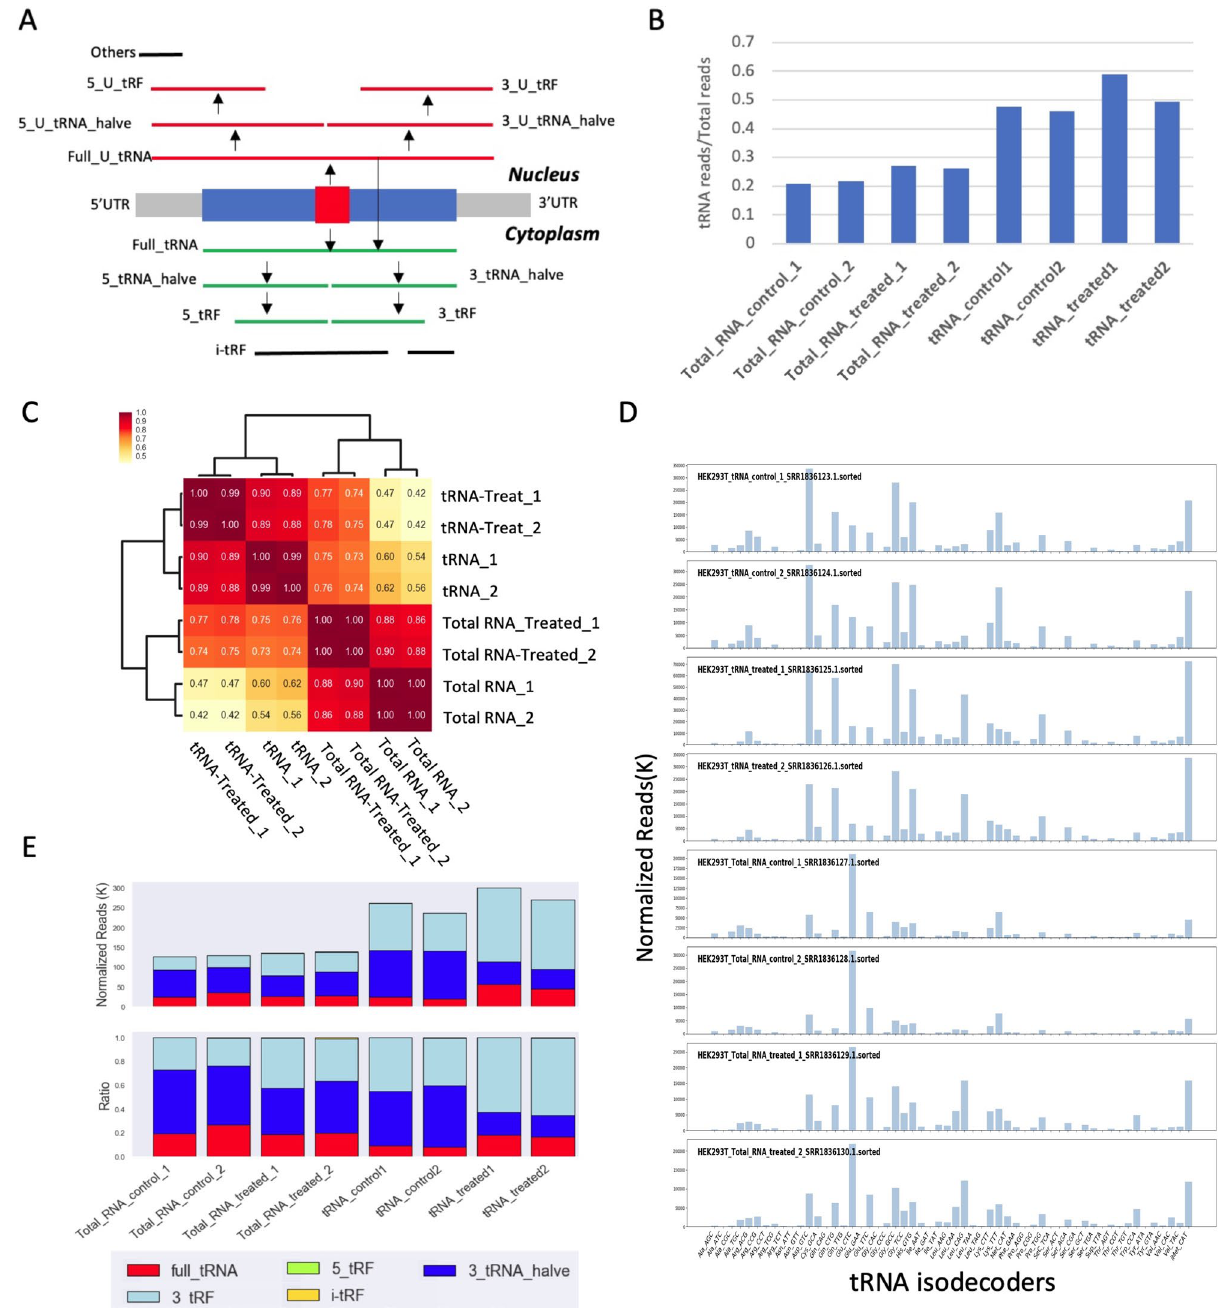
Figure 3. tRNA profiles of HEK293T cells in the DM-tRNA-Seq dataset. ( A ) Cartoon illustrates 12 types of tRF. The arrows represent the direction of tRNA processing; the red and dark blue rectangles in the middle represent anticodon and full-length tRNA. ( B ) Bar chart showing the proportion of tRNA-related reads in eight samples (two technical replicates for each strategy). ( C ) The cluster correlation matrix of tRNA expression profiles across all samples. The numbers in the matrix grids represent the square of the Pearson correlation coefficient (r 2 ). ( D ) The expression levels (normalized read number) of 56 tRNA isodecoders in eight samples. ( E ) The normalized read counts and ratio of tRFs in the experiments. tRFs are colored as shown in the